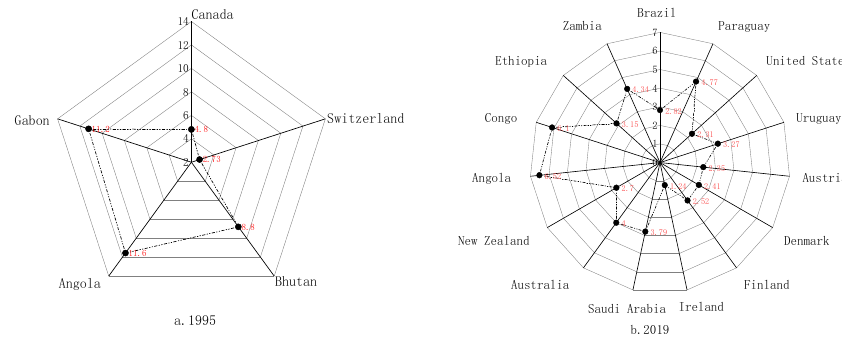
Figure 8. Energy supply index to use index ratio.